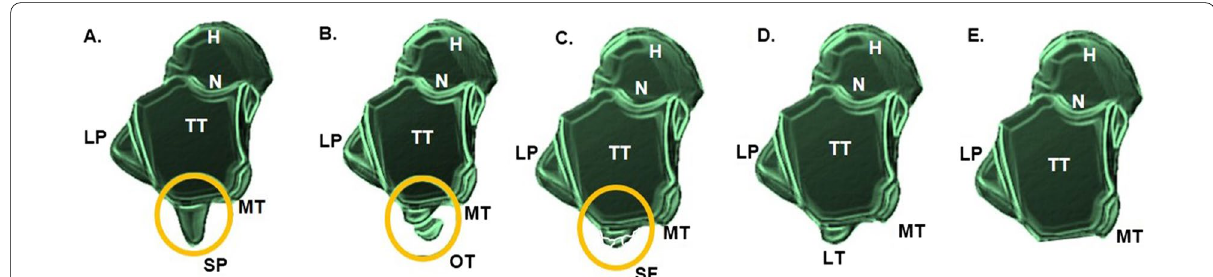
Fig. 1 The superior view of the talus (left side). A The Stieda Process (SP) (circle). It occurs as a result of the elongation of the lateral tubercle of the posterior process of the talus. B Os Trigonum (OT) (circle). OT occurs as a result of the separation of the lateral tubercle of the talus from the posterior process. OT is an accessory bone, unlike the SP. C The Shepherd fracture (SF) (circle) is a fracture resulting from the fracture of the lateral tubercle. D The typical talus with a normal lateral tubercle. E The figure shows the talus with a missing lateral tubercle (agenesis of lateral tubercle). H Head of the talus, LT Lateral tubercle, MT Medial tubercle, N Neck of the talus, OT Os Trigonum, SF Shepherd fracture, SP Stieda process, TT Trochlea of the